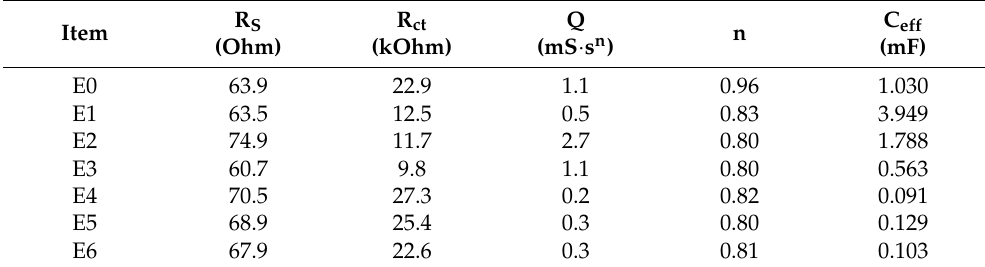
Table 2. Electrochemical data from EIS